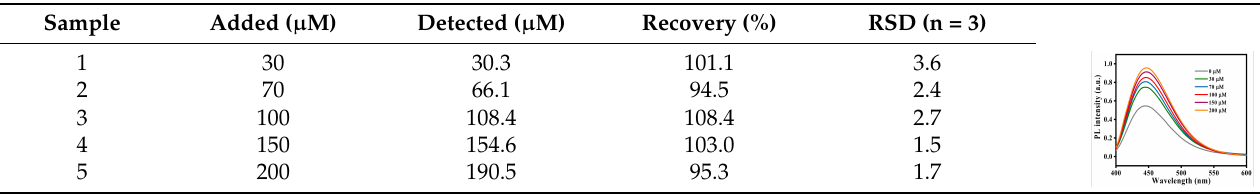
Table 2. GSH sensing performance in human